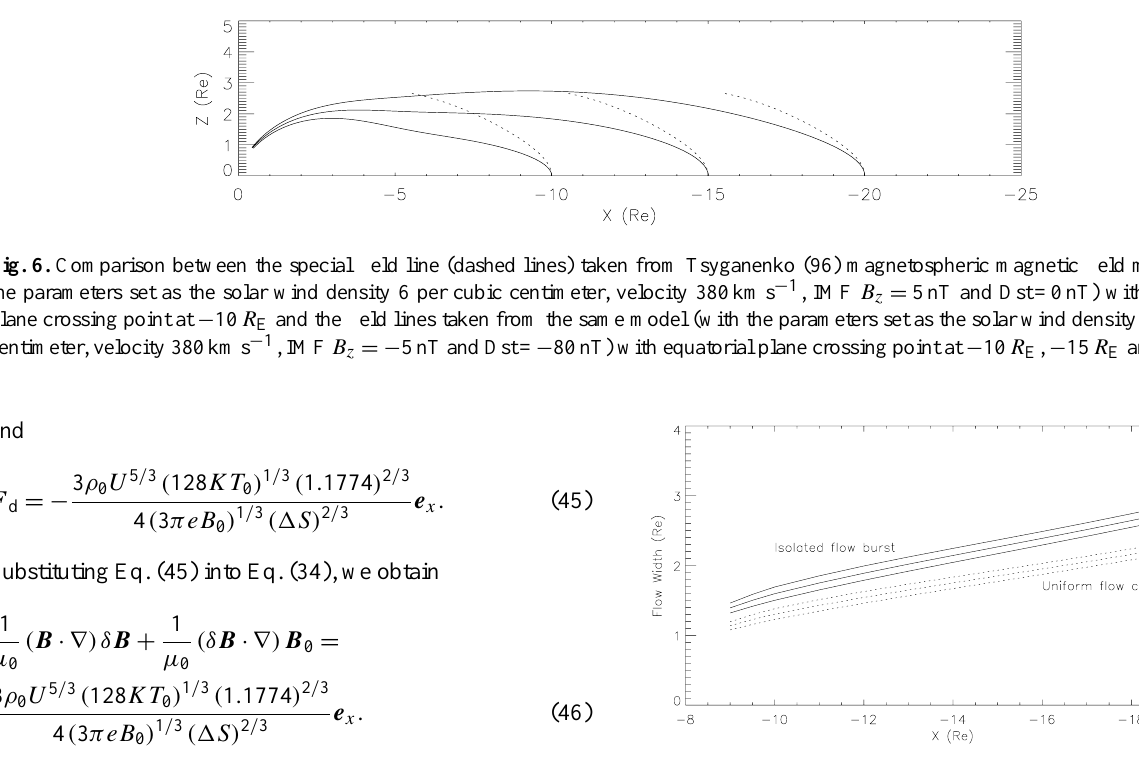
Fig. 7. Cross-tail width of fast flow. The three solid lines are for the isolated flow burst case (from top to bottom IMF= − 7.5nT, − 5.0nT, − 2.5nT); the three dashed lines are for uniform flow chan- nel case (from top to bottom IMF= − 7.5nT, − 5.0nT, −